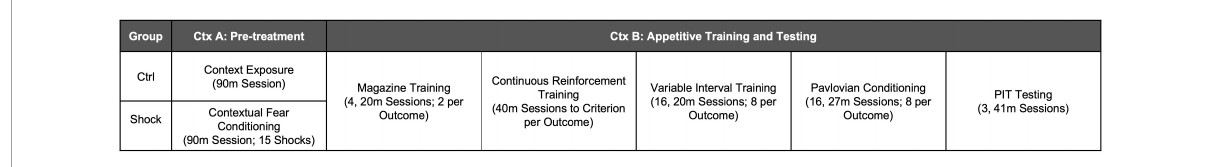
FIGURE2 Illustration of the experimental timeline for Experiment